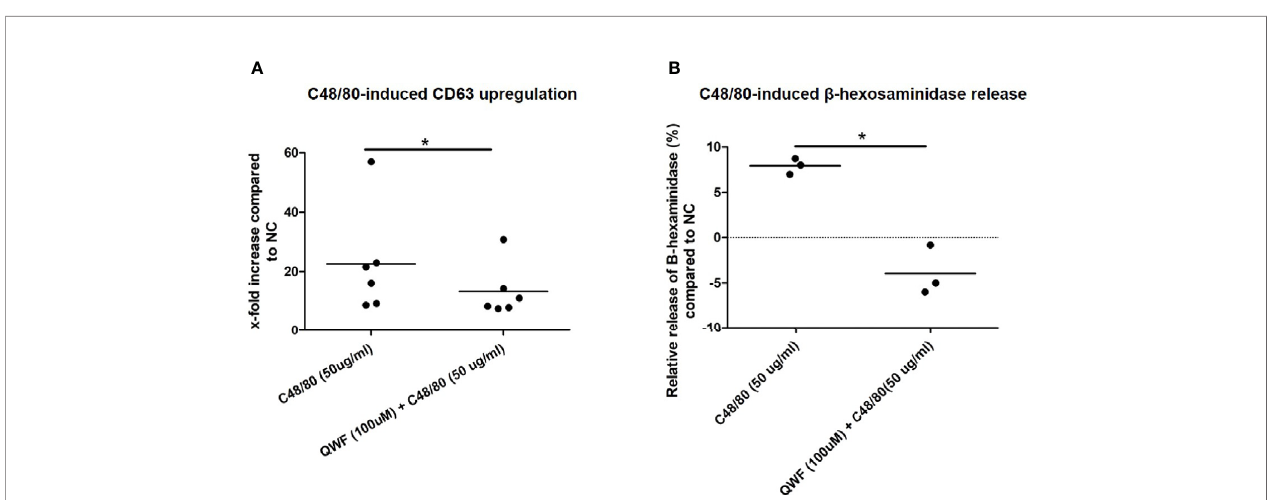
FIGURE 7 | QWF effectively inhibits C48/80 induced degranulation. (A) QWF effectively and signi fi cantly inhibits C48/80 induced degranulation of HMC1s, as measured by CD63 expression (*p 0.03, Wilcoxon rank test). (B) QWF effectively and signi fi cantly inhibits C48/80 induced degranulation of HMC1s, as measured by b -hexosaminidase release (*p 0.01). Relative increases compared with the negative control are shown, the dashed line thus represents the negative control condition.